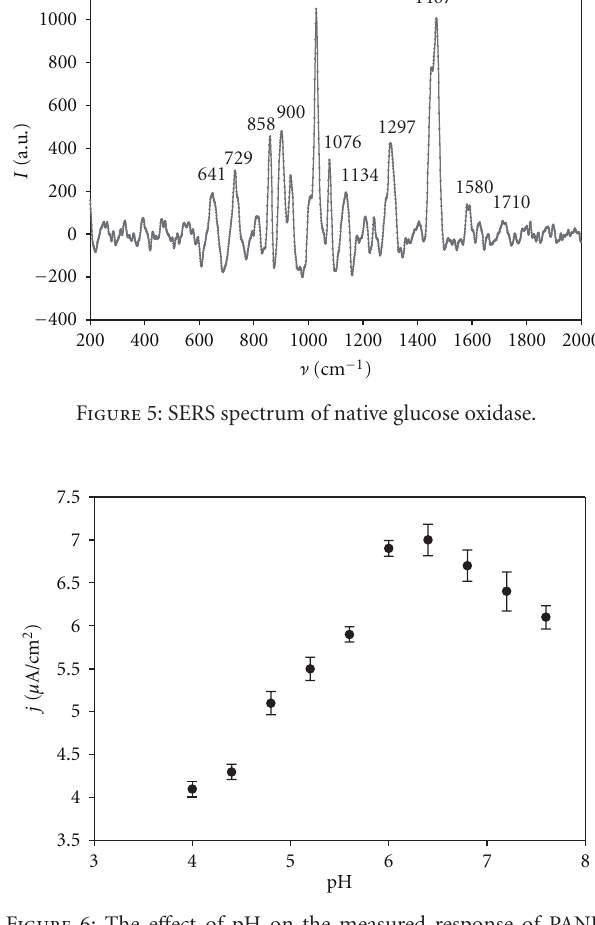
Figure 6: The e ff ect of pH on the measured response of PANI- gold nanorod-enzyme film by amperometric detection of 0.5mM glucose in 0.1 M phosphate bu ff er in the range of 4.0–8.0.